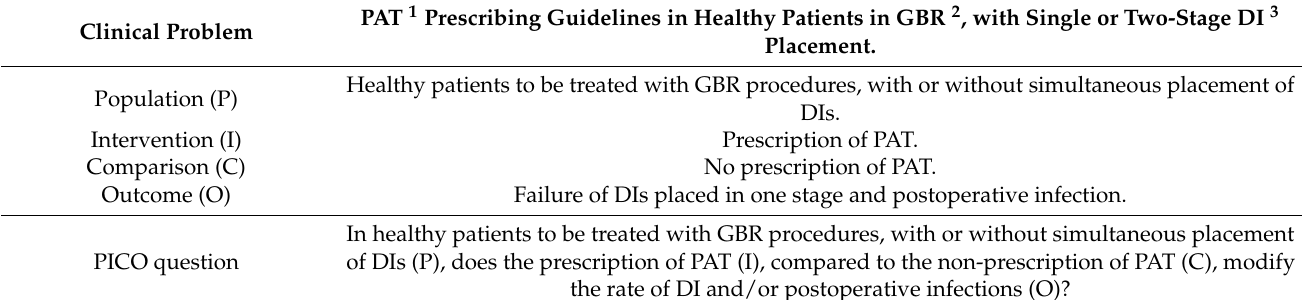
Table 4. PICO question 4.